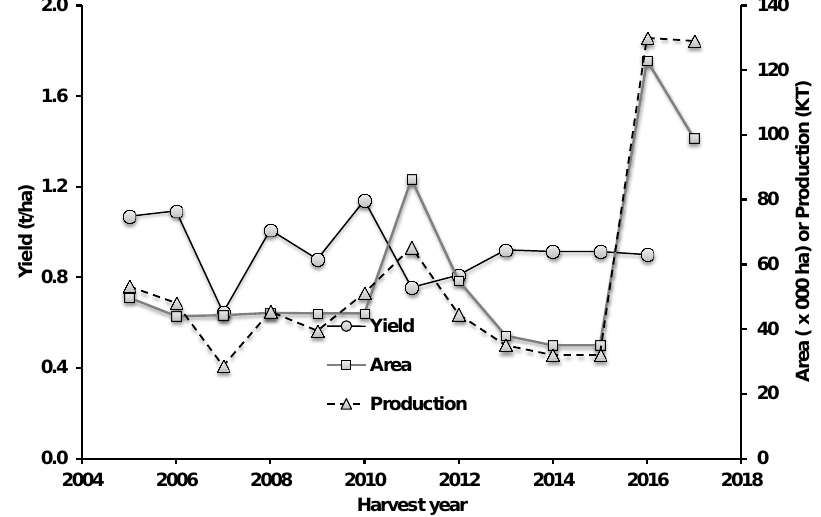
Figure 1. Yield, area, and production of mungbean in Australia (source: agriculture.gov.au/abares/research-topics/agricultural-commodities).